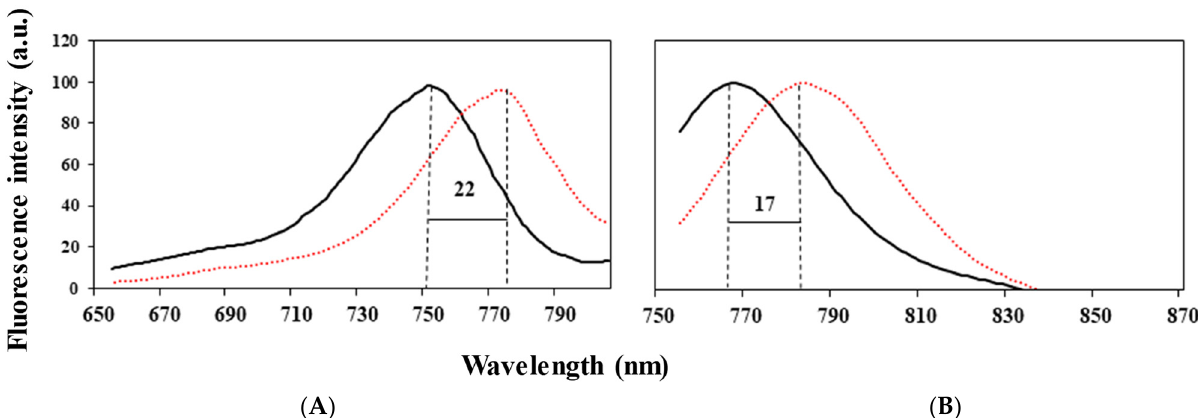
Figure 7. Fluorescence intensity shift of P(RGD)/Pal,Alp NCs. ( A ) Excitation and ( B ) emission peaks for free Cy7 (black line) and Cy7-conjugated NCs (orange dotted line).